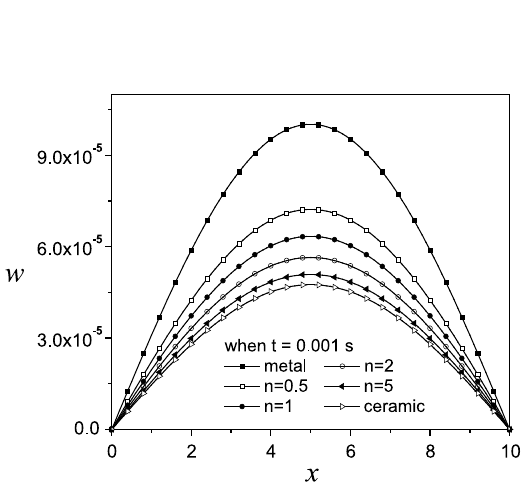
Fig. 20. Deflection of the mid-plane for the simply supported FGPM cylindrical shell imposed by a sinusoidal distributed load, when t = 0 . 001 .